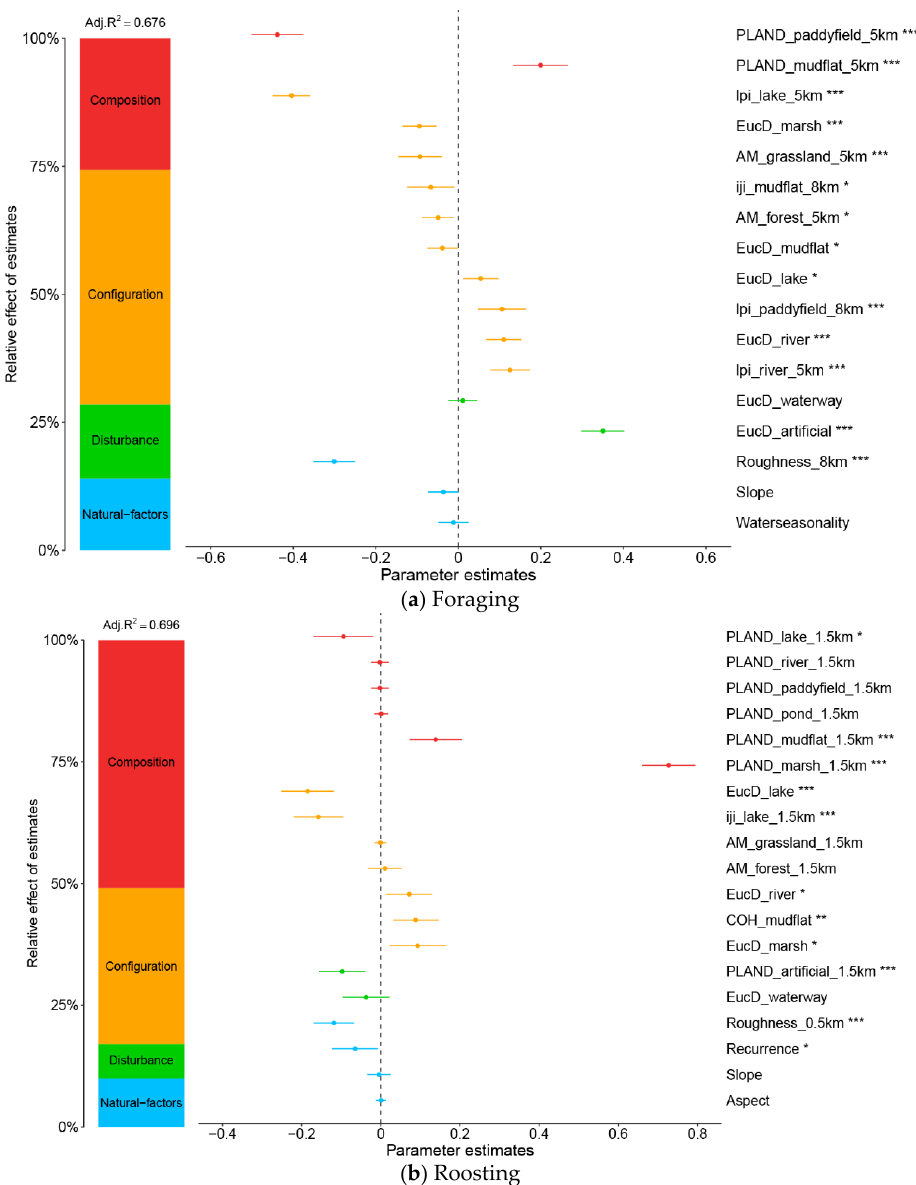
Figure 3. Effect of factors on habitat selection. ( a ) Foraging; ( b ) Roosting. Average parameter estimates (standardized regression coefficients) of model predictors, associated 95% confidence intervals and relative importance of each factor, expressed as the percentage of explained variance. The adjusted ( adj. ) R 2 of the averaged model and the p value of each predictor are given as * p < 0.05; ** p < 0.01; *** p < 0.001.